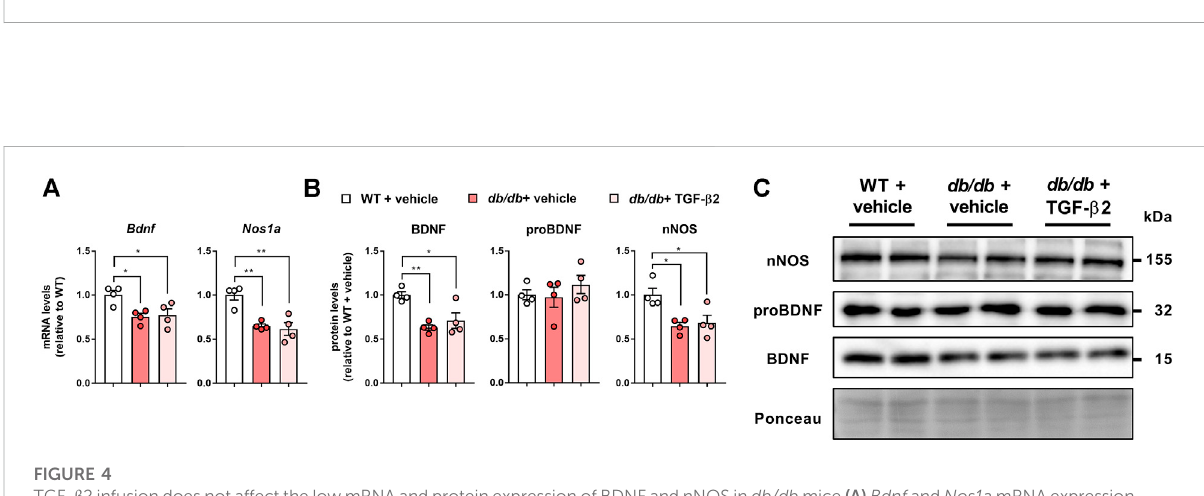
FIGURE 3 TGF- β 2infusionreducestheexpressionofgenesencodingpro-in fl ammatorymoleculesinpgWAT,butnotinthehippocampus,of db/db mice. Tnfa and Il6 mRNAexpressioninthe (A) pgWATand (B) hippocampus (C) Hippocampal Tgfb2 mRNAexpression inWT, db/db + vehicle,and db/db + TGF- β 2 mice. Data are presented as the mean ± SE ( n = 4/group). The dots represent individual data points. *** p < 0.001; * p <